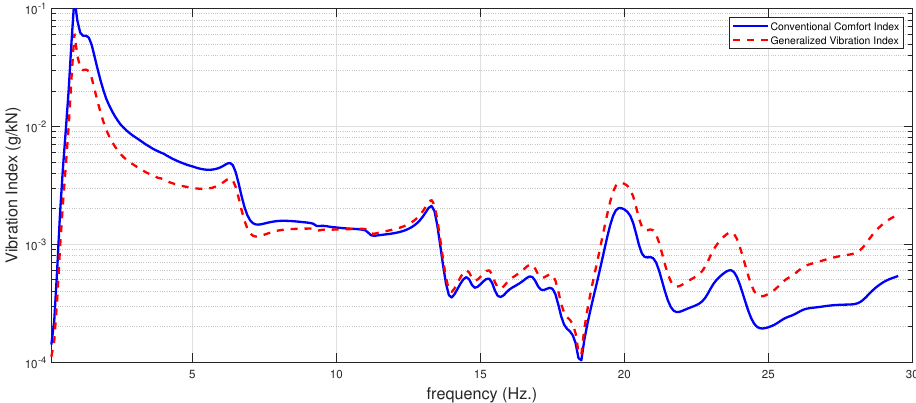
Figure 8. Proposed generalized vibration index, compared with conventional vibration exposure index for equal weights on comfort, handling, visual, and feet vibration indices.